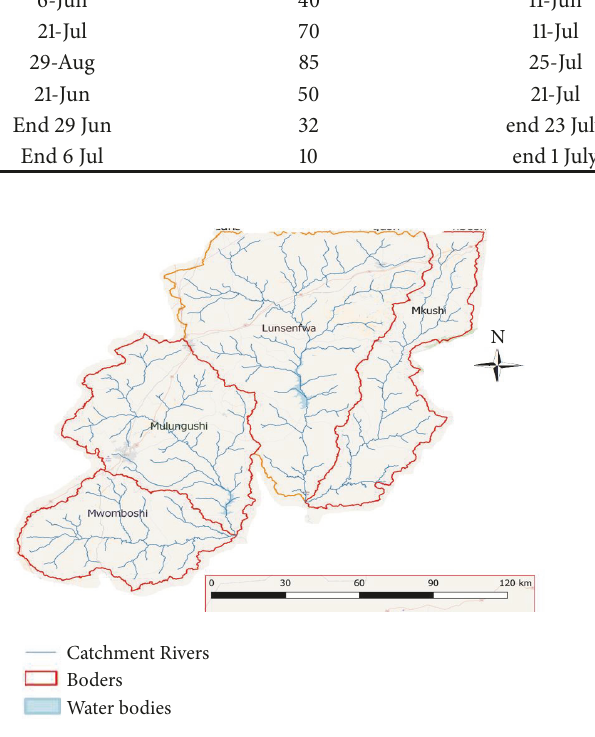
Figure 1: Catchment orientation and river